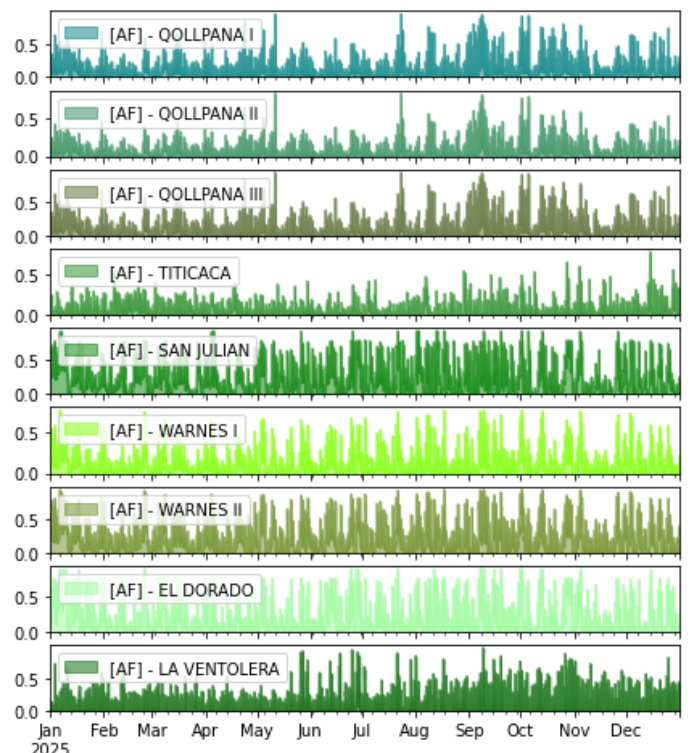
planned wind turbines from [68–70] (e.g., Figures 16 and 17).